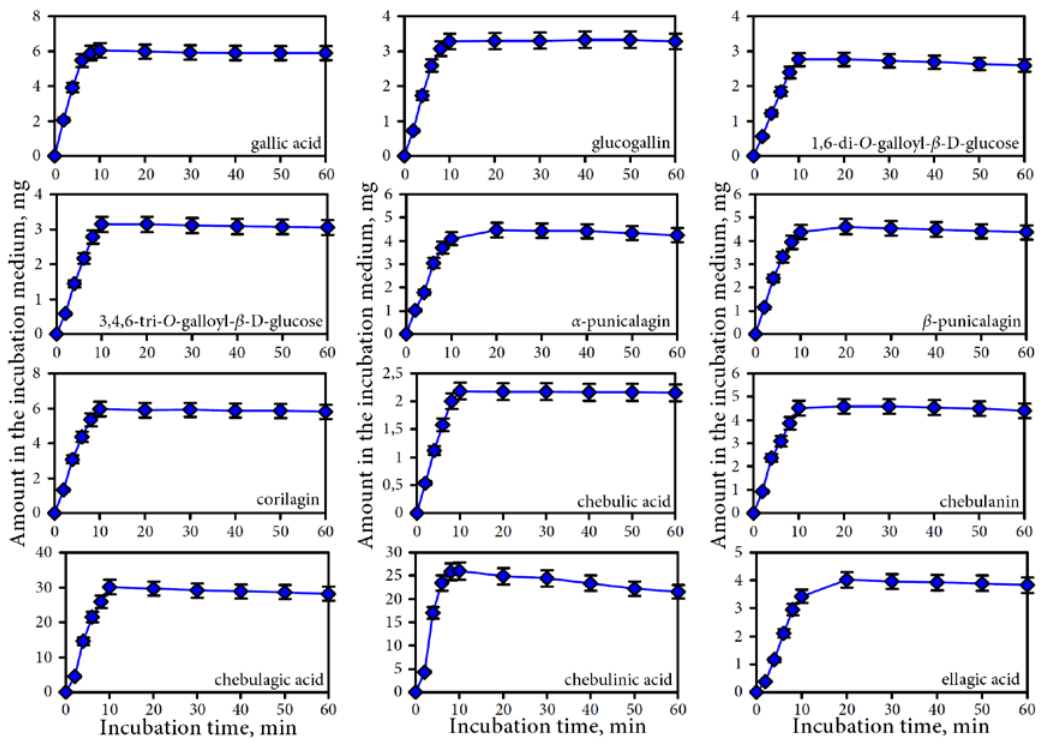
Figure 3. Dynamic of release of phenolic compounds in gastric media for separate compounds.